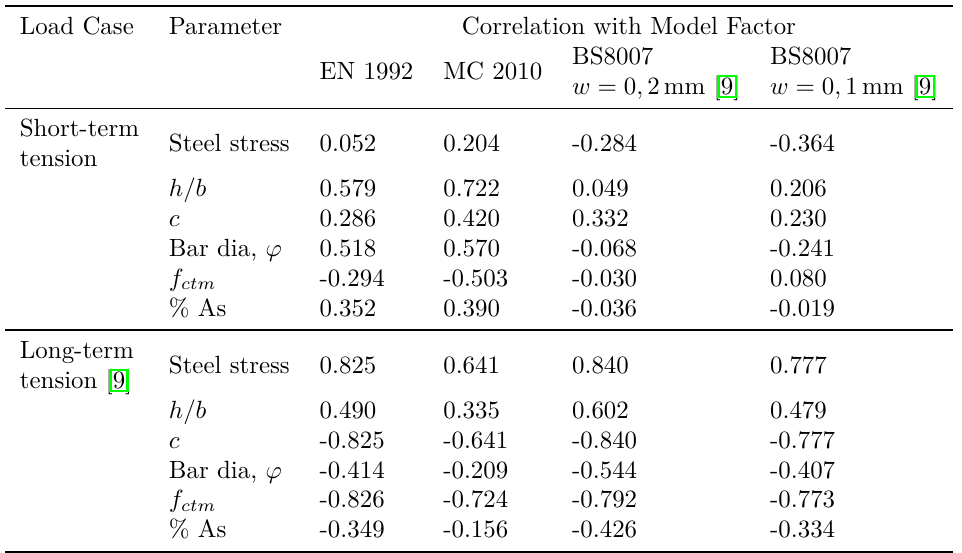
Table 4. Pearson’s correlation matrix between model uncertainty & model parameters.